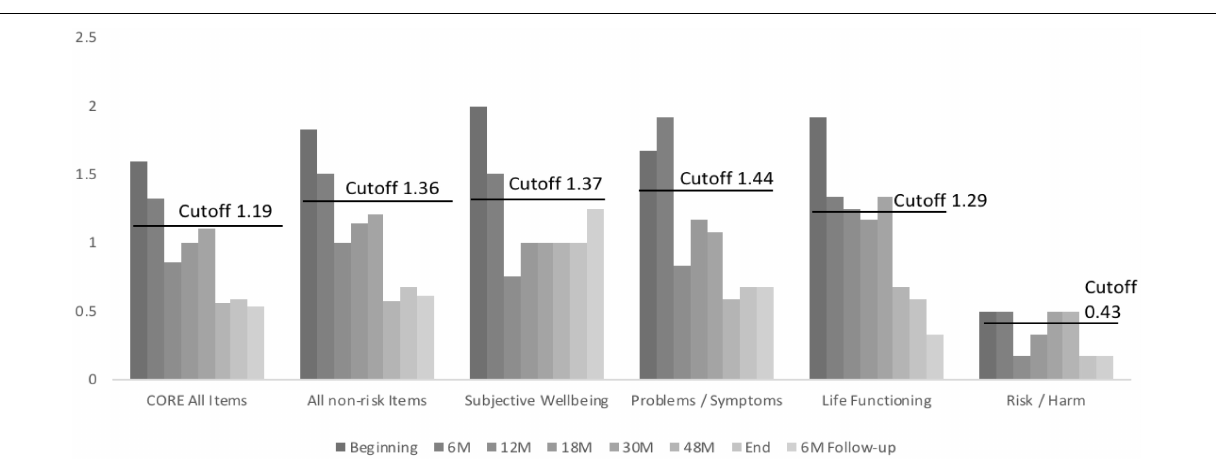
FIGURE 3 | Group PQ means of scores over time.